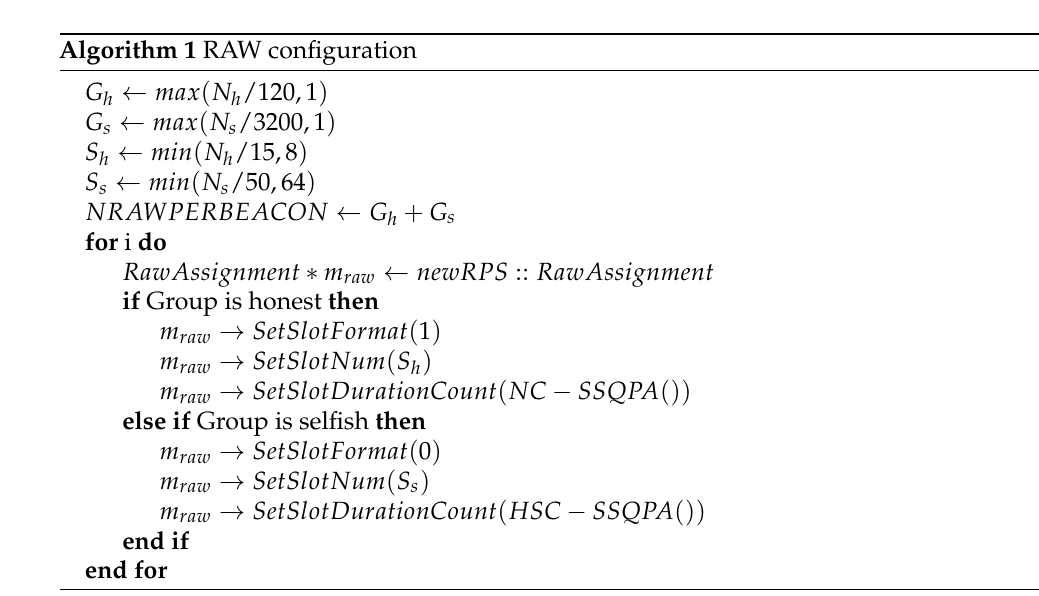
Algorithm 1 RAW